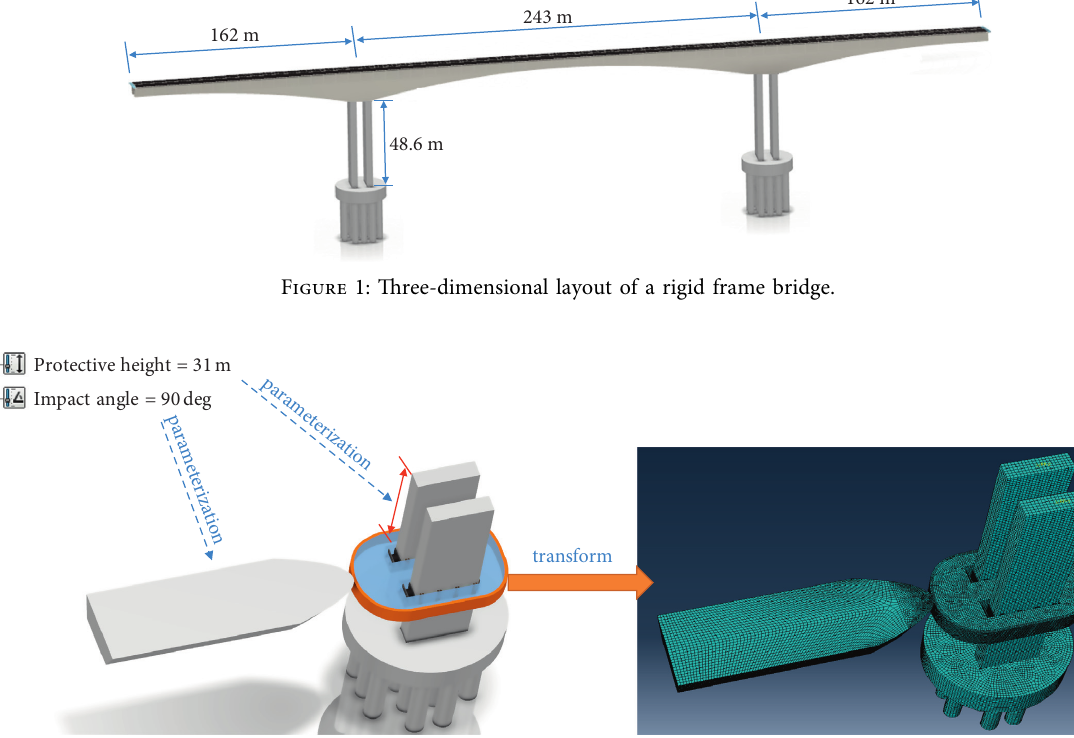
Figure 2: Schematic diagram of anti-collision facilities for ships and floating box.